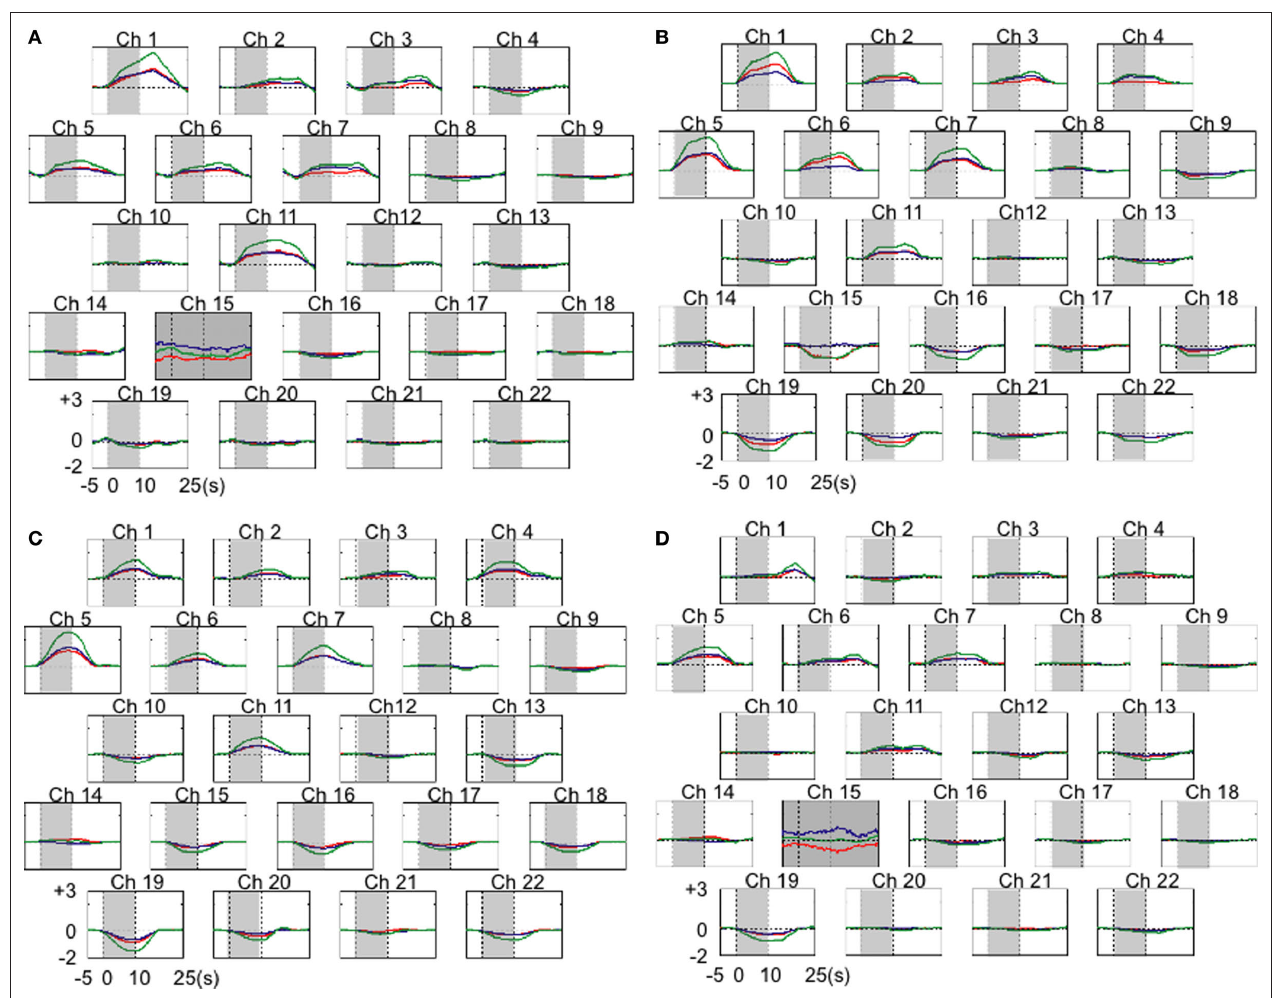
blue, and total-Hb in green. Shades indicate a 10-s stimulation period. Units of hemodynamic change are given as mmol-mm. Gray color of the background in Ch 15 in (A) and (D) indicates the recording of overall background noise there in the sessions. It hindered the reliable averaging of the time course of hemodynamic changes. Thus these data were excluded from further